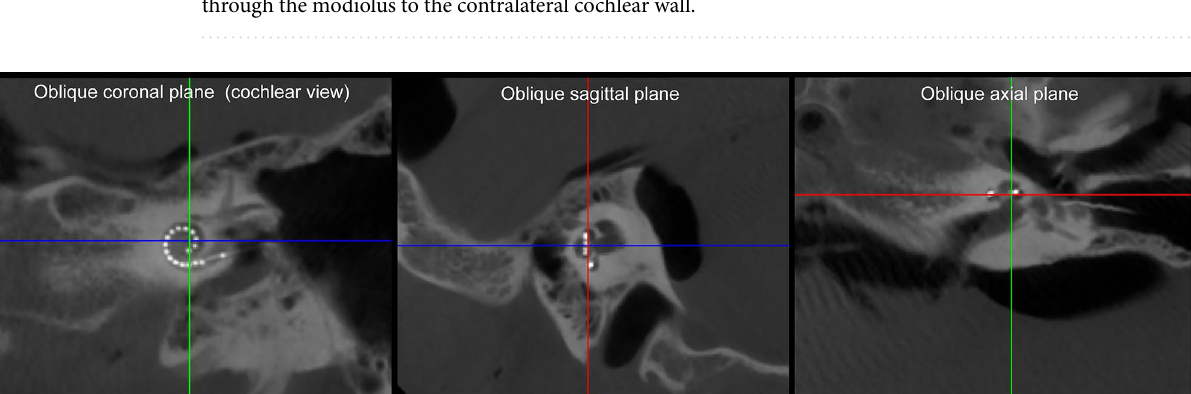
Figure 10. In the cochlear view reconstruction of CB-CT scan both insertion depth angle and distance A can be measured. The 360° line is drawn perpendicular to a line between round window entry and middle of upper part of the posterior semicircular canal. The insertion depth angle is measured by adding 360° to the angle between the apical electrode and the 360° line. Distance A (dashed line), an indirect measure proportional to cochlear duct length, is measured as the length of the line from the point of the array entering the RW or CO, through the modiolus to the contralateral cochlear wall.